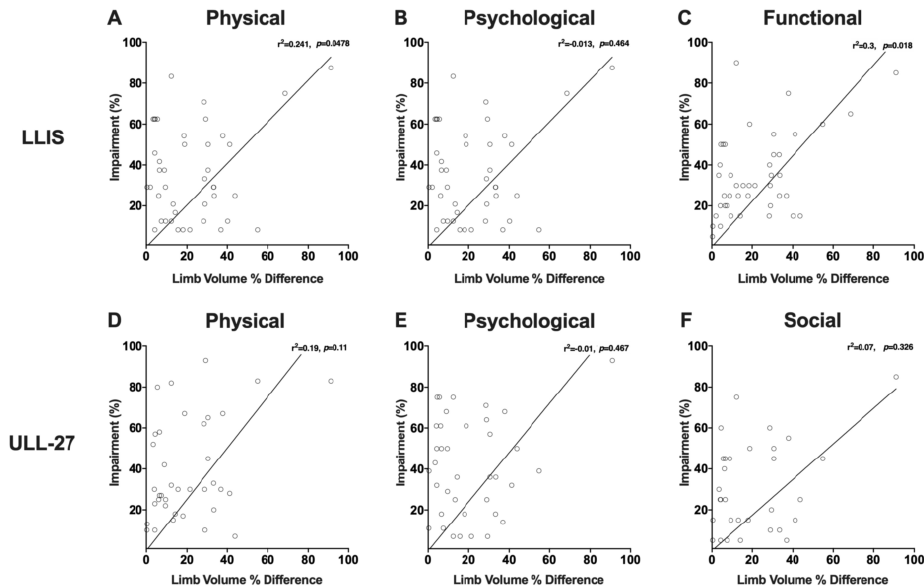
Figure 6. ( A ) Correlation plot of limb volume di ff erence (%) vs. LLIS physical domain impairment score (%). ( B ) Correlation plot of limb volume di ff erence (%) vs. LLIS psychological domain impairment score (%). ( C ) Correlation plot of limb volume di ff erence (%) vs. LLIS functional domain impairment score (%). ( D ) Correlation plot of limb volume di ff erence (%) vs. ULL-27 physical domain impairment score (%). ( E ) Correlation plot of limb volume di ff erence (%) vs. ULL-27 psychological domain impairment score (%). ( F ) Correlation plot of limb volume di ff erence (%) vs. ULL-27 social domain impairment score